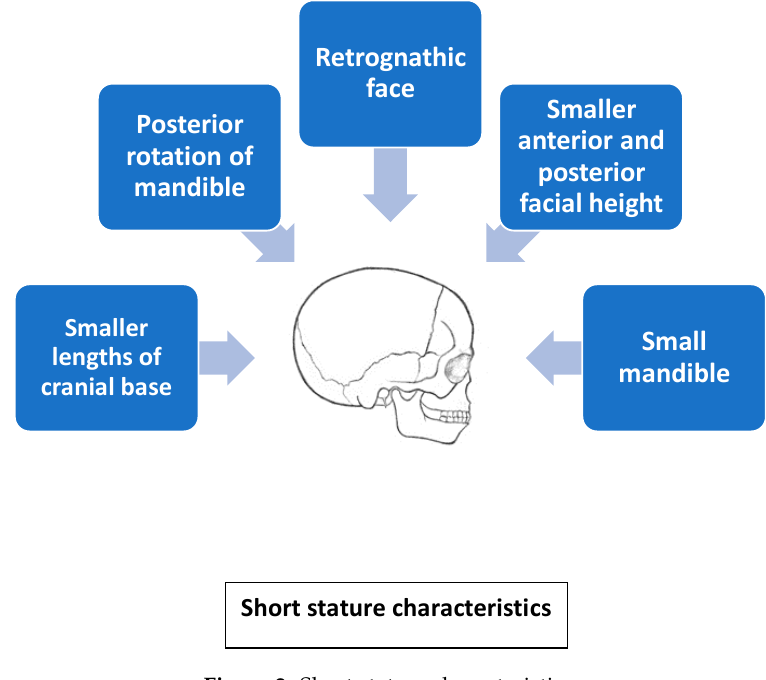
Figure 2. Short stature characteristics.